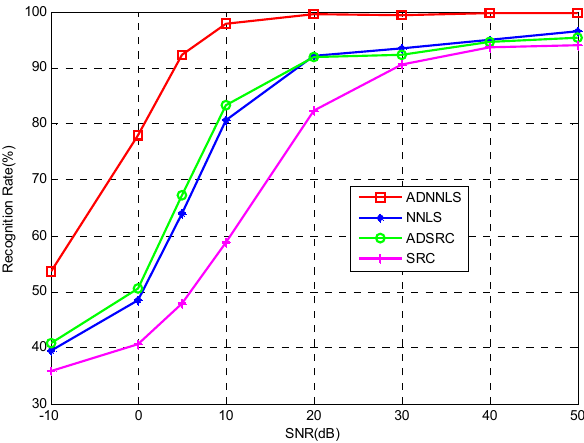
Figure 16. Performance of the algorithm with varying SNRs.